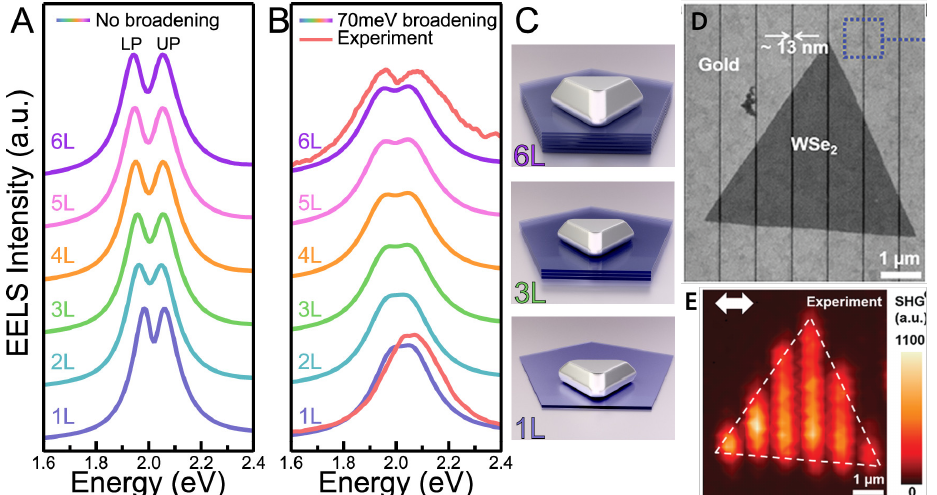
Figure 3. ( A – C ) The influence of WS 2 thickness and EELS energy resolution on Rabi splitting. Electron energy loss spectra are calculated for a perfectly tuned coupled system consisting of a 75 nm Ag truncated nanopyramid on a WS 2 flake on a 20 nm Si 3 N 4 support, with WS 2 thickness varying between one and six layers. The perfect adjustment is achieved by adjusting the height of each truncated nanopyramid while maintaining the length of the bottom face and the angles of the side face. Two scenarios are considered: ( A ) no spectral broadening and ( B ) an assumed energy resolution of 70 meV, which is the upper limit for 40–70 meV resolution experiments. Experimental electron energy loss spectra from coupled truncated nanopyramids on one and six layers of WS 2 are compared to the red spectra in panel ( B ). ( C ) Schematic models of the zero-detuned condition for WS 2 thicknesses of one, three, and six layers, with changes in truncated nanopyramid height to achieve perfect tuning. ( D , E ) Pump-laser-polarization-dependent second harmonic generation (SHG) mapping of monolayer WSe 2 on gold trenches. ( D ) Image obtained from scanning electron microscopy (SEM) of a single-crystalline monolayer WSe 2 flake on trenches having a spacing of 910 nm. ( E ) Experimental mappings of SHG obtained under resonant and nonresonant excitations for the same WSe 2 flake located on the trenches shown in the SEM image. The white dashed lines delineate the edges of the WSe 2 flake. The white arrows indicate the polarization directions of the pump laser, which are perpendicular to the trenches. The fabricated 150 nm-thick flat surface of monolayer WSe 2 and sub-20 nm-wide gold trenches on flexible substrates demonstrated a ∼ 7000-fold enhanced SHG, without resonance broadening or background in the spectra, compared to WSe 2 on as-grown sapphire substrates. ( A – C ) Reproduced with permission from [53]. Copyright 2019 by American Chemical Society. ( D , E ) Reproduced with permission from [54]. Copyright 2018 by American Chemical